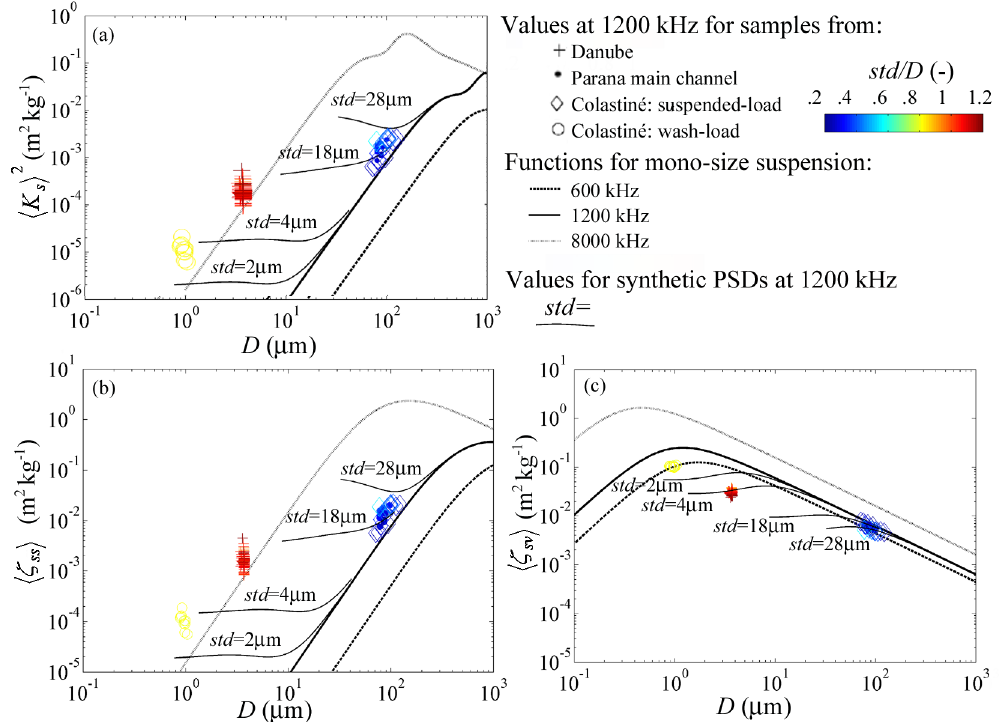
Figure 8. ( a ) Backscattering coefficient; ( b ) scattering attenuation normalized coefficient and ( c ) viscous attenuation normalized coefficient: values at 1200 kHz among measured number PSDs, functions at three frequencies (600, 1200 and 8000 kHz) for mono-size suspension and values at 1200 kHz for synthetic number PSDs (Figure 9) characterized with fixed values of the std (2, 4, 18 and 28 μ m).